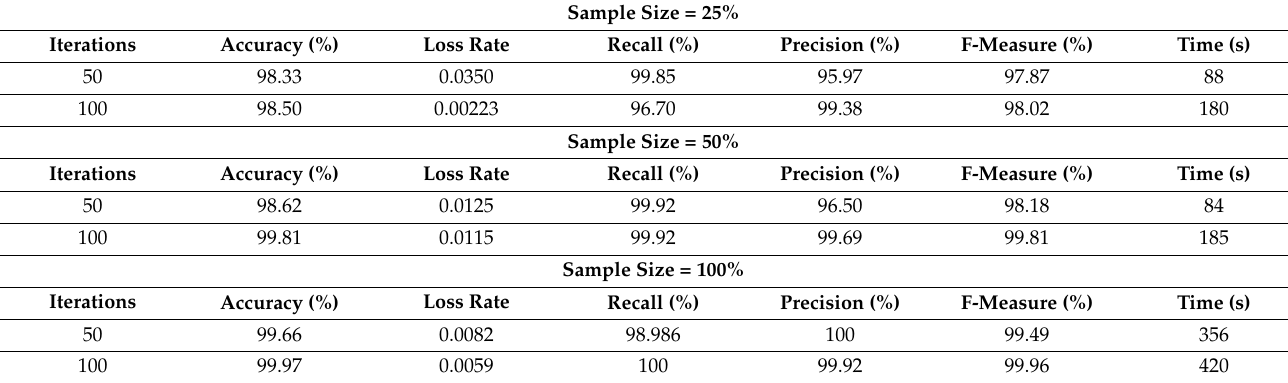
Table 6. Experimental results.